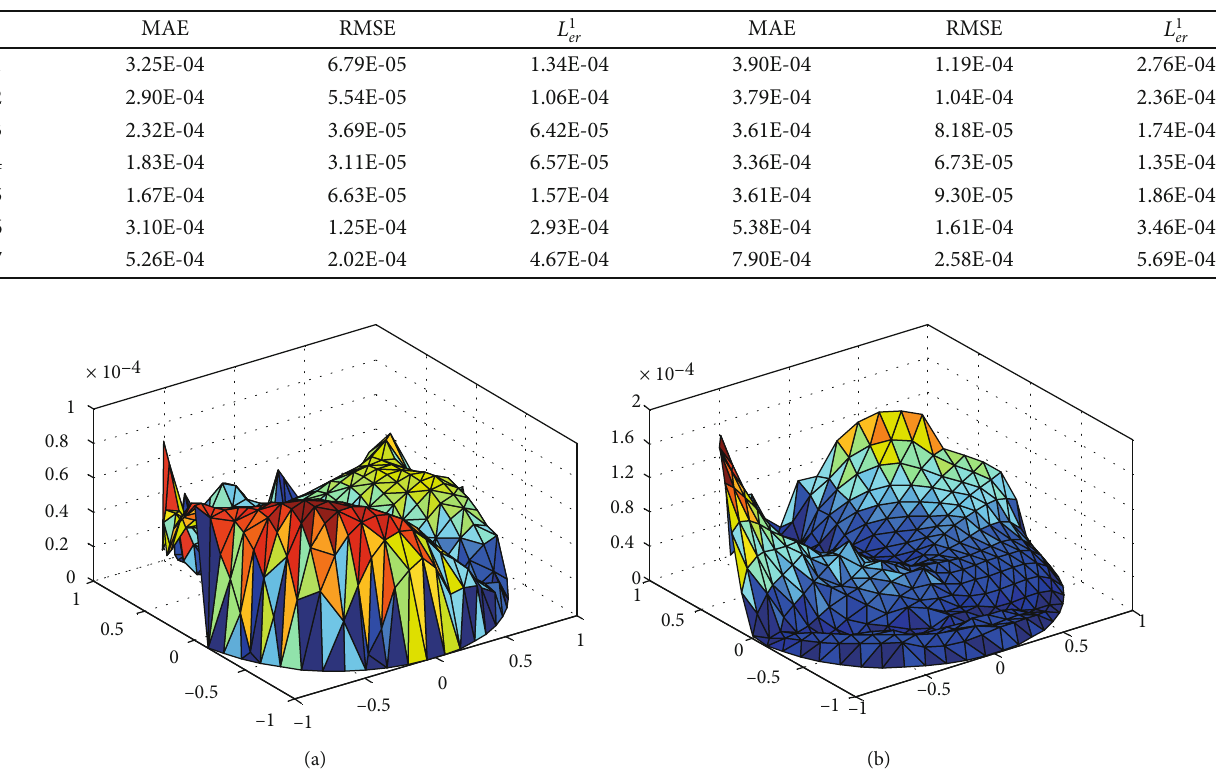
= 10 . Uniform (a) and circular (b). Example 1 using Dirichlet and Neumann Figure 6: Absolute Errors at t = 1 with N t